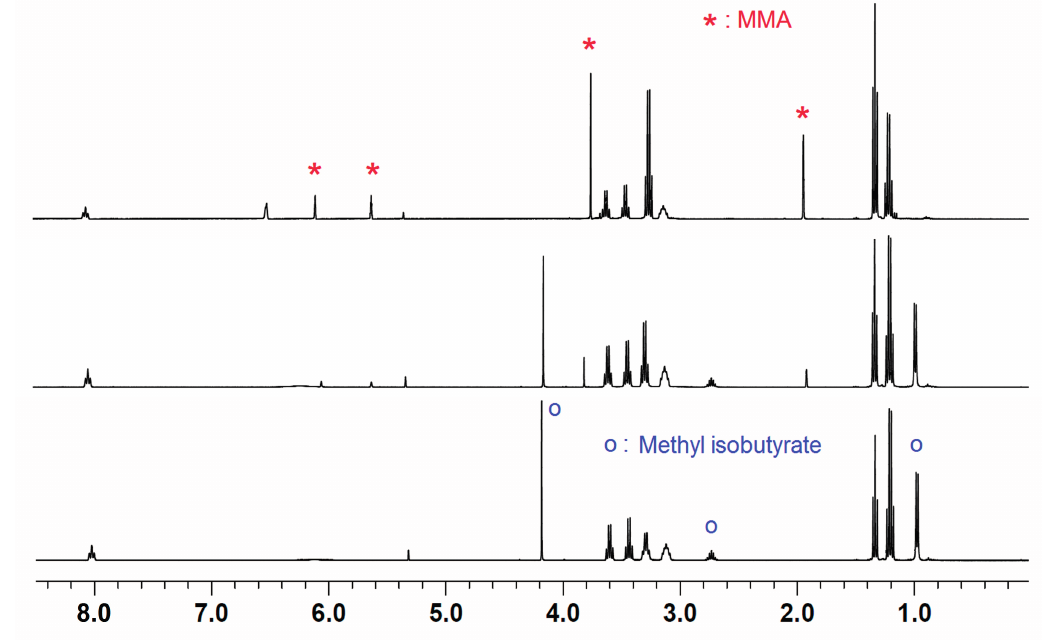
Figure 3. 1 H-NMR spectra (CD 2 Cl 2 ) of a mixture of Et 3 N/B(C 6 F 5 ) 3 /MMA in the ratio of 1:1:1 ( top ), 1:1.5:1 ( middle ) and 1:2:1 ( bottom , some amount of Et 3 N-H ··· H-B(C 6 F 5 ) 3 remains due to a slight deficiency of